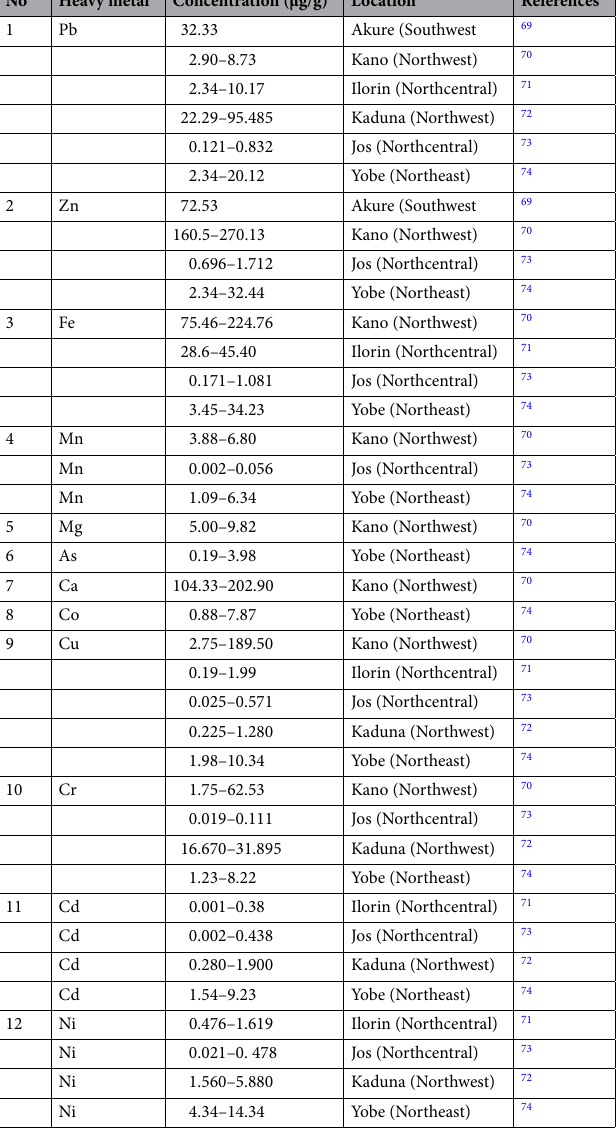
Table 5. Heavy metal contents in atmospheric dust in selected parts of the study area.